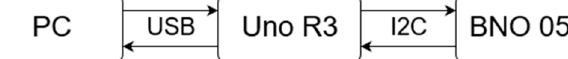
Figure 2. Data flow of the communication.